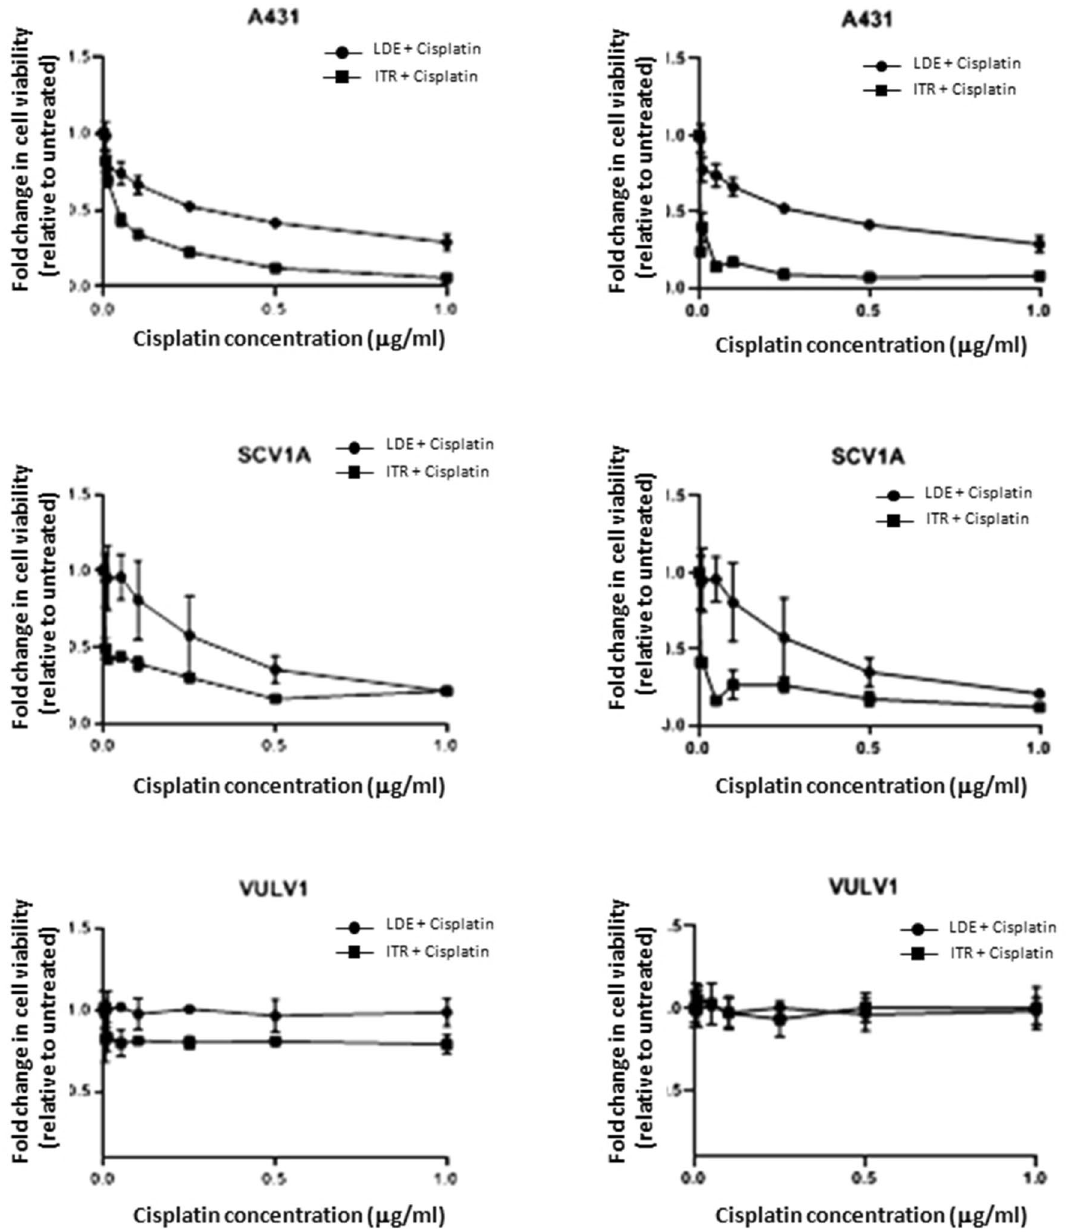
Figure 6. The SMO inhibitors, LDE-225 and Itraconazole, sensitise Hh-dependent VSCC-derived cell lines to Cisplatin. Co-treatment of Hh-dependent VSCC cell lines with LDE-225 or Itraconazole at IC50 dose and escalating dose Cisplatin leads to a profound leftward shift of the cell viability curve, indicating that Hh-inhibitors sensitise these cells to Cisplatin, but this effect was not observed in Hh-independent cell, UCI- VULV1. All experiments were performed three